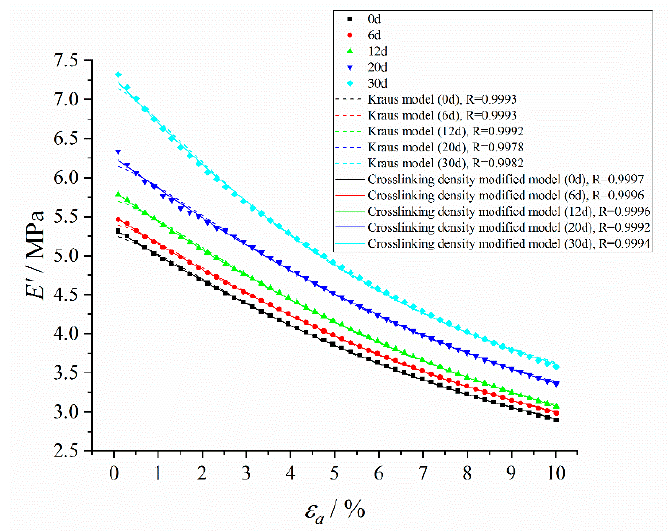
Figure 11. ThestoragemodulusfittingcurvesofthecrosslinkingdensitymodifiedmodelandKrausmodel. Polymers 2020 , 12 , 403 Figure 11. The storage modulus fitting curves of the crosslinking density modified model and Kraus